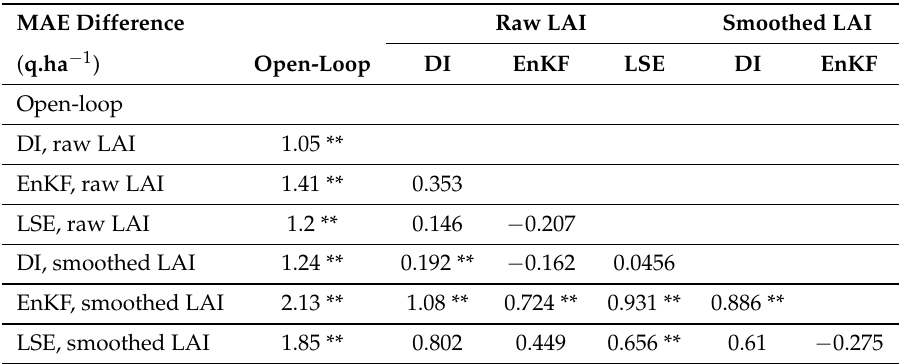
Table 5. Side-by-side comparison of assimilation methods (‘past weather’ alternative). This table provides the differences in mean absolute error (MAE) between methods. The sign ‘**’ designates the side-by-side comparisons where there was a significant difference in MAE, with a p -value less than 0.01 in the non parametric paired Wilcoxon test. MAE Difference Raw LAI Smoothed LAI ( q.ha − 1